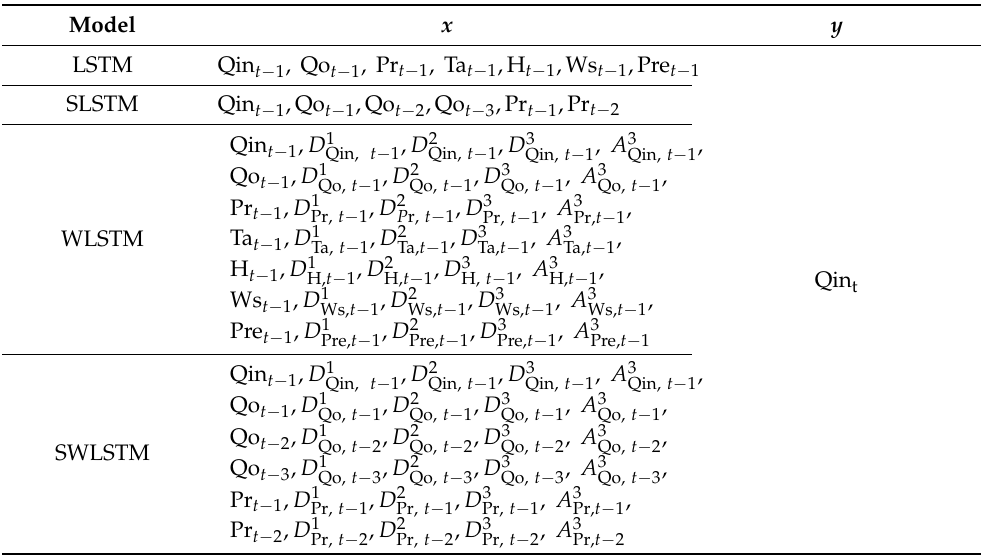
Table 4. Summary of input and output variables used for training four data-driven models (LSTM, SLSTM, WSLTM, and SWLSTM).